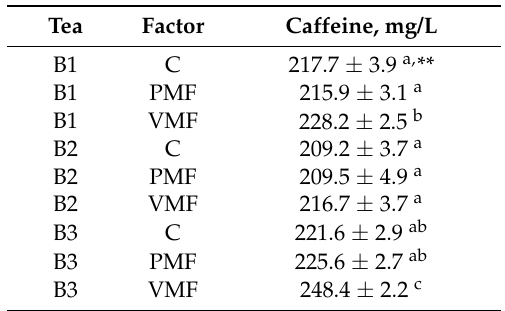
Table 3. Analytical findings showing contents of caffeine in black tea infusions extracted with the use of a magnetic field under control conditions.